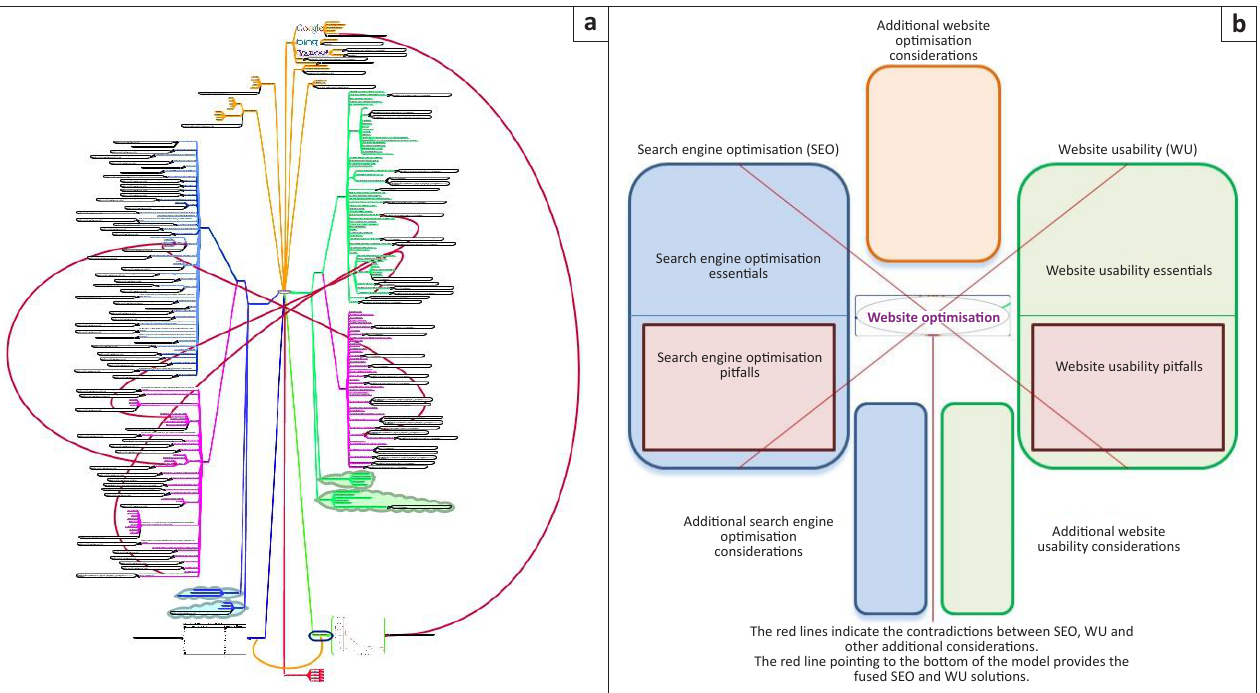
FIGURE 3: The fused search engine optimisation and website usability model (a) and the fused search engine optimisation and website usability model key and colour codes (b). (A scalable image of the model is available at